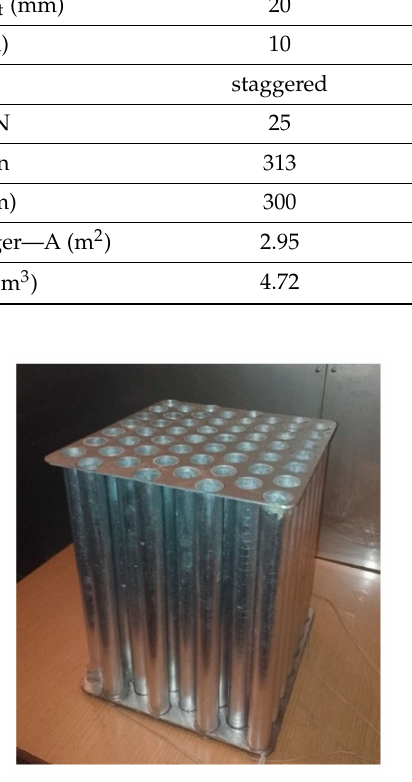
Figure 6. Heat exchanger 2 made of cylinders with an external diameter of 25 mm and a wall thickness of 1 mm.